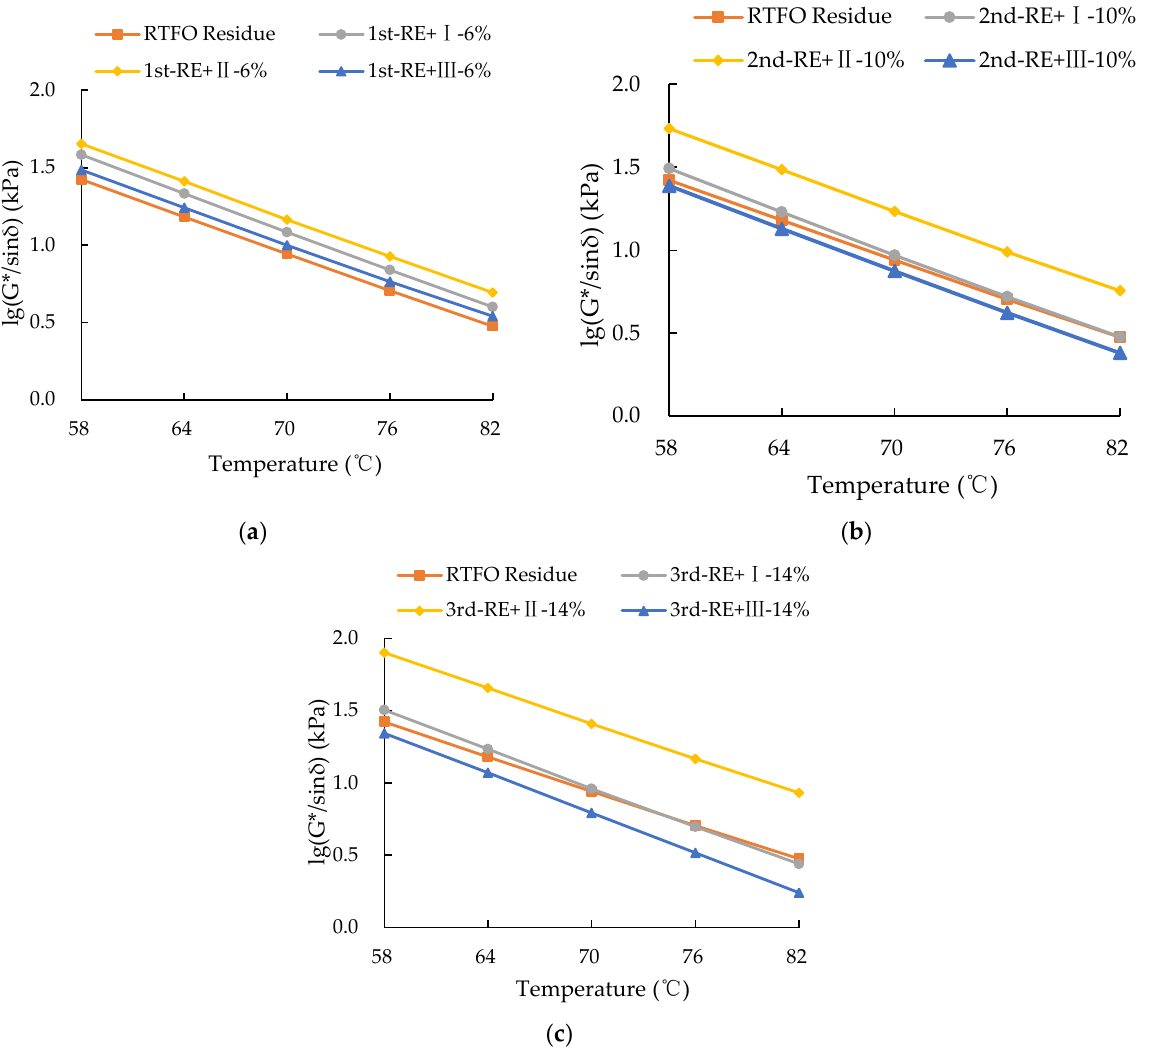
Figure 4. Rutting factor of SBS asphalt-binders at different rejuvenation cycles: ( a ) First cycle; ( b ) Second cycle; ( c ) Third cycle.